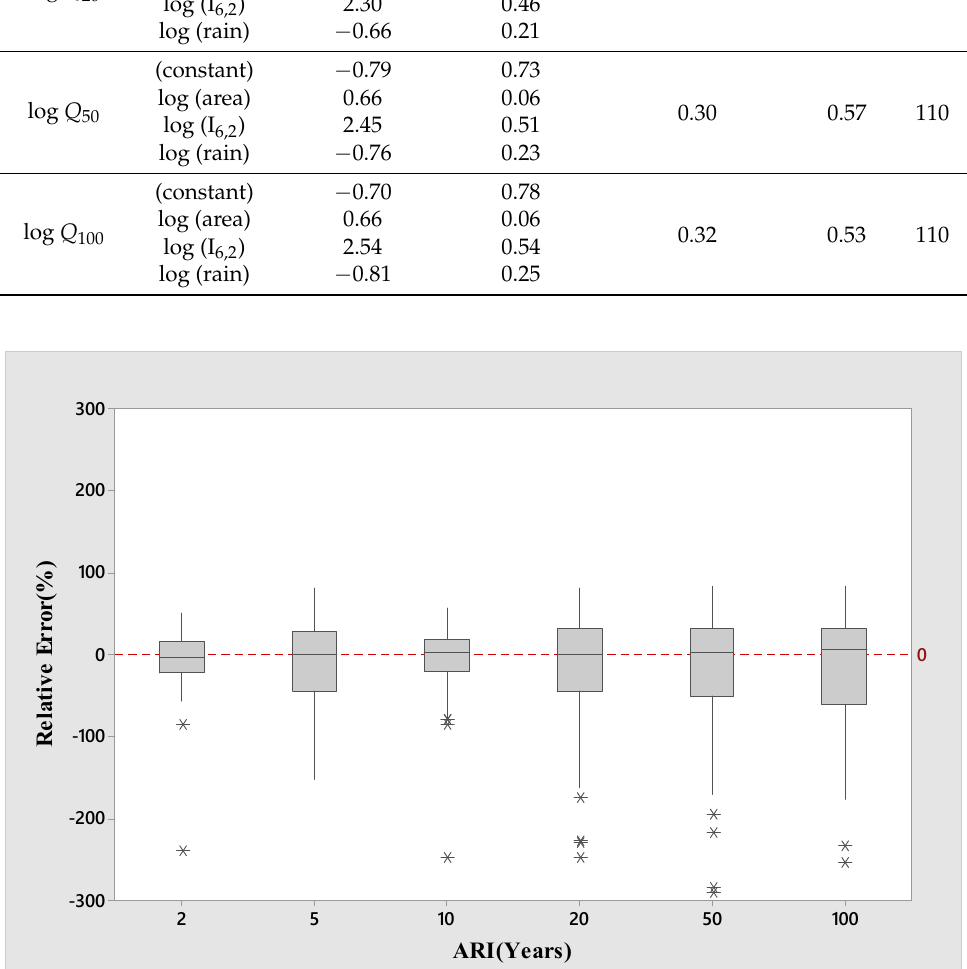
Figure 2. Boxplots of relative error (RE) values for log-log linear model of combined group (* represents outliers).